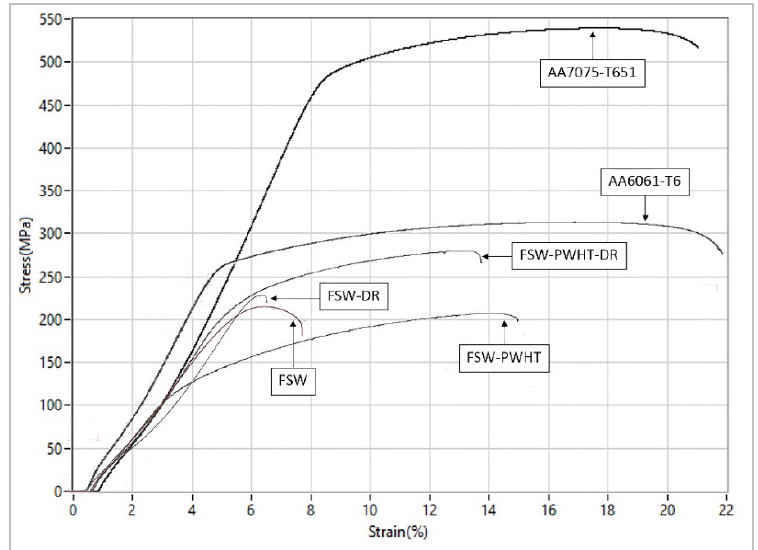
Figure 13. Tensile strength of the workpieces.